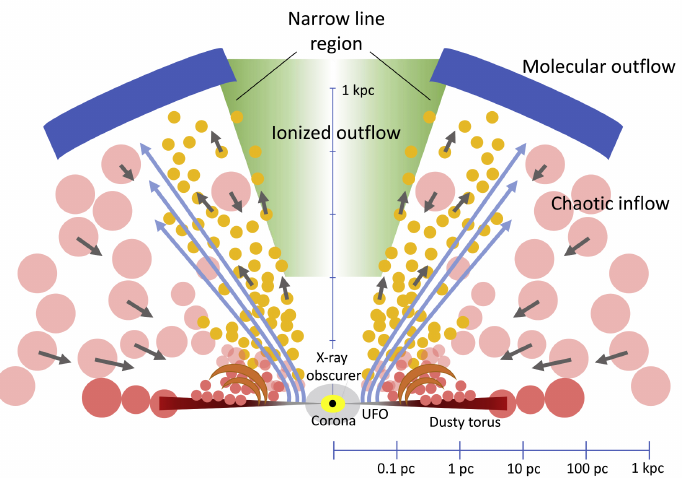
Figure 12. Schematic of AGN in the late-stage merger explaining how the AGN may end up deeply buried. Galaxy interaction induces chaotic quasi-spherical inflows (light pink) toward the dusty torus (dark pink), which block the X-ray emission from the corona, and in turn, launch the UV-line driven winds (blue arrows) and drive outflowing materials (orange). These inflows and outflows are responsible for keeping the AGN obscured within molecular outflows found at larger radii. Figure adapted from Yamada et al. [194]; © AAS, reproduced with